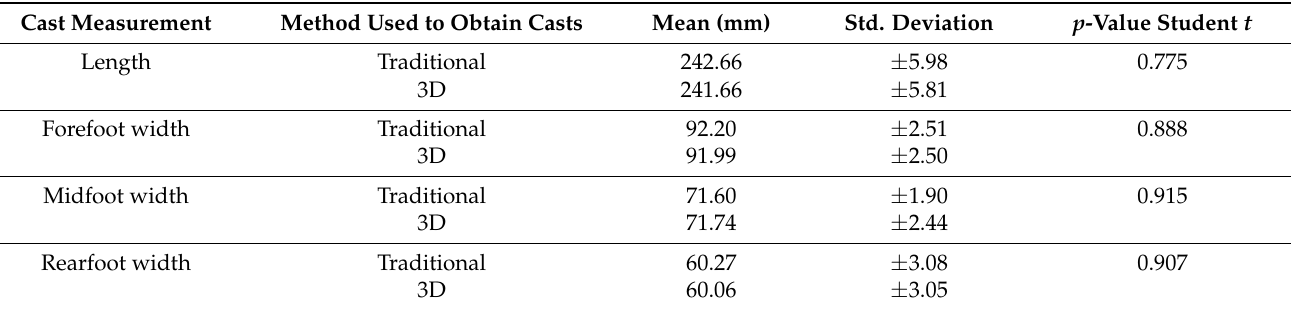
Table 2. Contrast of means of the measurements taken on the cast by fabrication